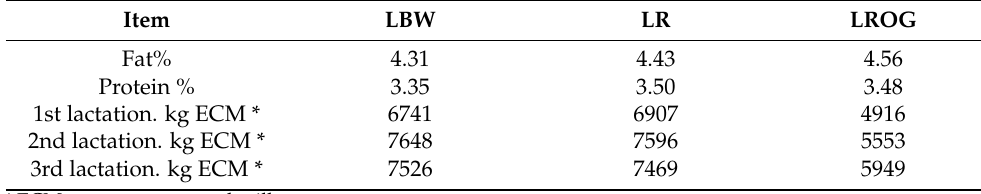
Table 3. Mean phenotypes for 305-d ECM, fat and protein (kg) for the LBW, LR and LROG. Item LBW